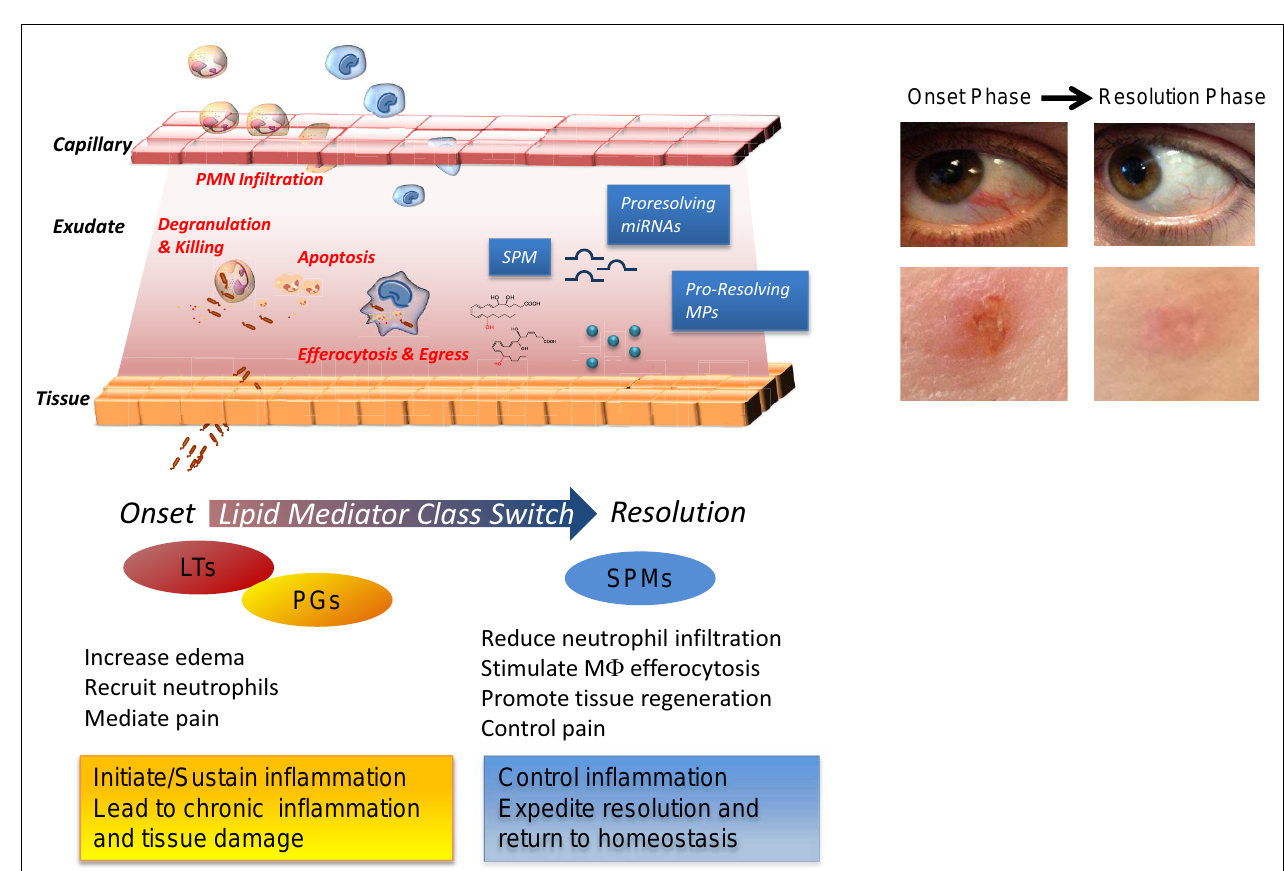
inflammation is almost completely resolved and homeostasis re-established. (Pictures were taken using a Lumix SZ7 digital camera). Lipid autacoids prostaglandins (PGs) and leukotrienes (LTs) are classical mediators of the onset phase of inflammation, promoting edema, PMN recruitment, and pain. possess pro-resolving